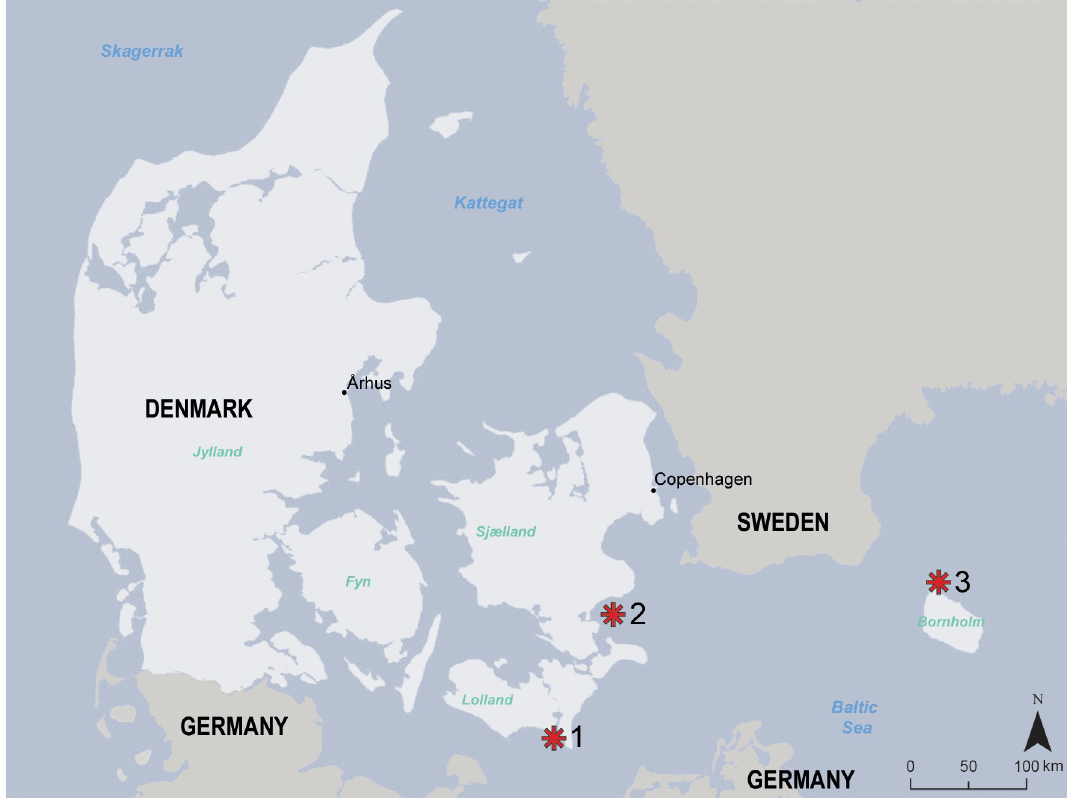
Fig 2. Map indicating the localities (asterisks) where the Baltic grey seals ( Halichoerus grypus grypus ) had been collected in 1889– 1890. Five skulls belonged to animals culled on R ø dsand sandbank (locality 1), one to an animal culled near Faxe on Sjaelland (locality 2), and one to an animal from Christians ø on Bornholm (locality